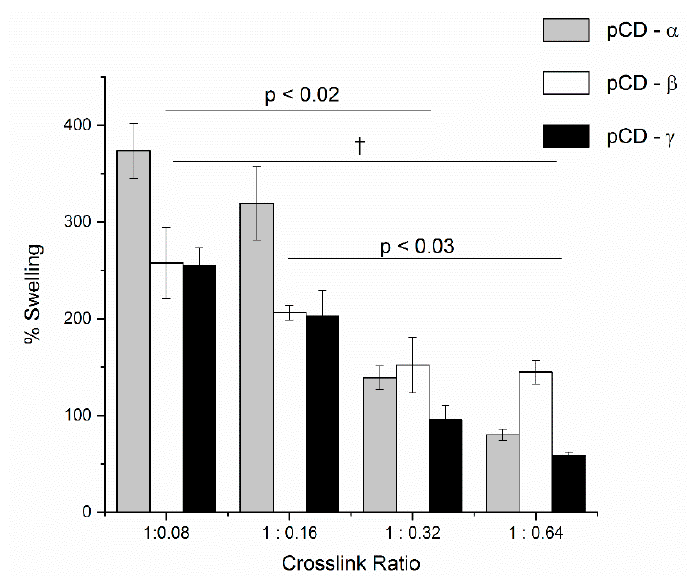
Figure 1. Increasing ratios of polymerized cyclodextrin (pCD) crosslink density decreases water swelling. pCD hydrogel disks were weighed dry (W 1 ) placed in water at 37 ◦ C for 24 h, blotted, and weighed (W 2 ). Swelling was calculated according to (W 2 − W 1 ) / W 1 . Two-way analysis of variance